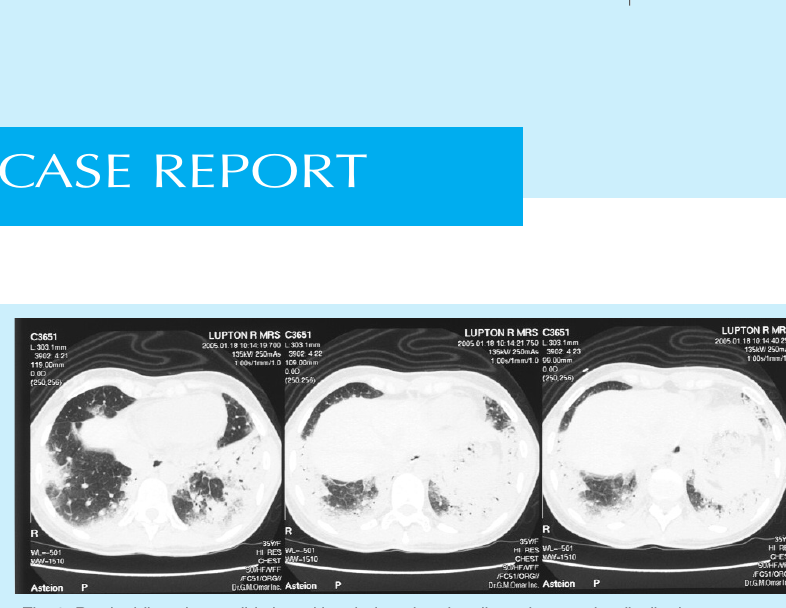
Fig. 2. Patchy bibasal consolidation with subpleural and peribronchovascular distribution.